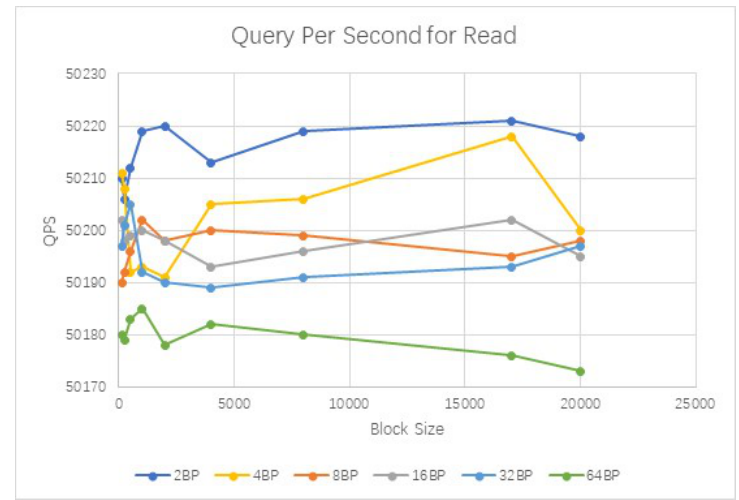
Figure 8. Comparison of the query overhead for reads.